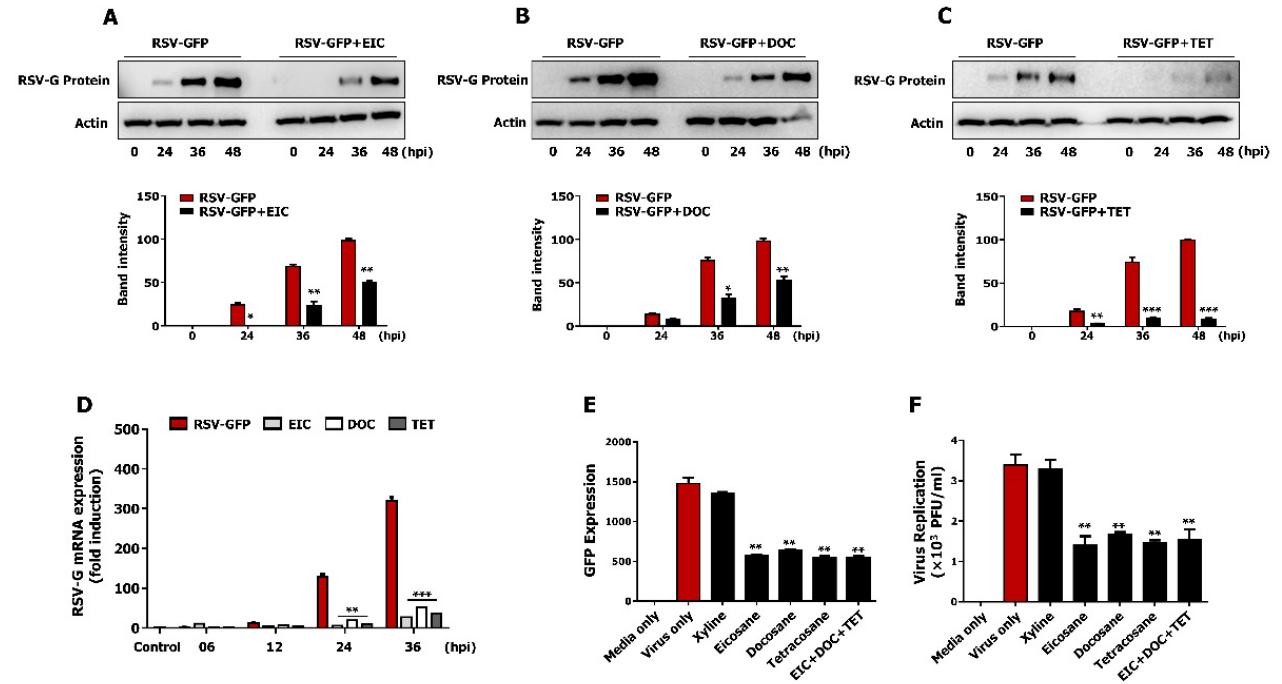
Figure 5. Antiviral effect of eicosane (EIC), docosane (DOC) and tetracosane (TET) in vitro. RSV–GFP infected cells were treated with 100 mM of EIC, DOC, and TET at 2 hpi, cells were harvested at indicated time points. ( A – C ) RSV-G protein expression was determined by immunoblotting with an anti-RSV-G protein antibody, and the intensity of the RSV-G was quantified. ( D ) RSV-G protein mRNA transcription level was determined by qRT-PCR. GAPDH was used for normalization. ( E , F ) Infected cells were treated with 100 mM concentration of EIC, DOC, TET, and a combination of EIC, DOC, and TET at 2 hpi and ( E ) GFP absorbance levels were measured by Glomax multi-detection luminometer (Promega) after 48 hpi. ( F ) Viruses were titrated from the cell supernatant and cells by standard plaque assay. GFP absorbance and virus titer expressed as mean ± SD. Error bars indicate the range of values obtained from counting duplicates in three independent experiments (* p < 0.05 ** p < 0.01 *** p < 0.001 regarded as significant difference).